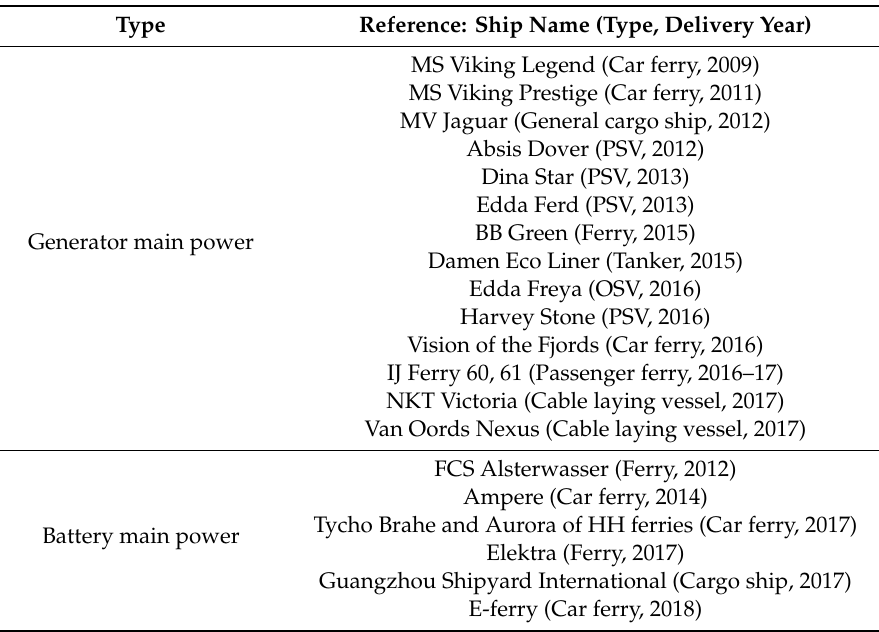
Table 1. References of the DC-gird system in